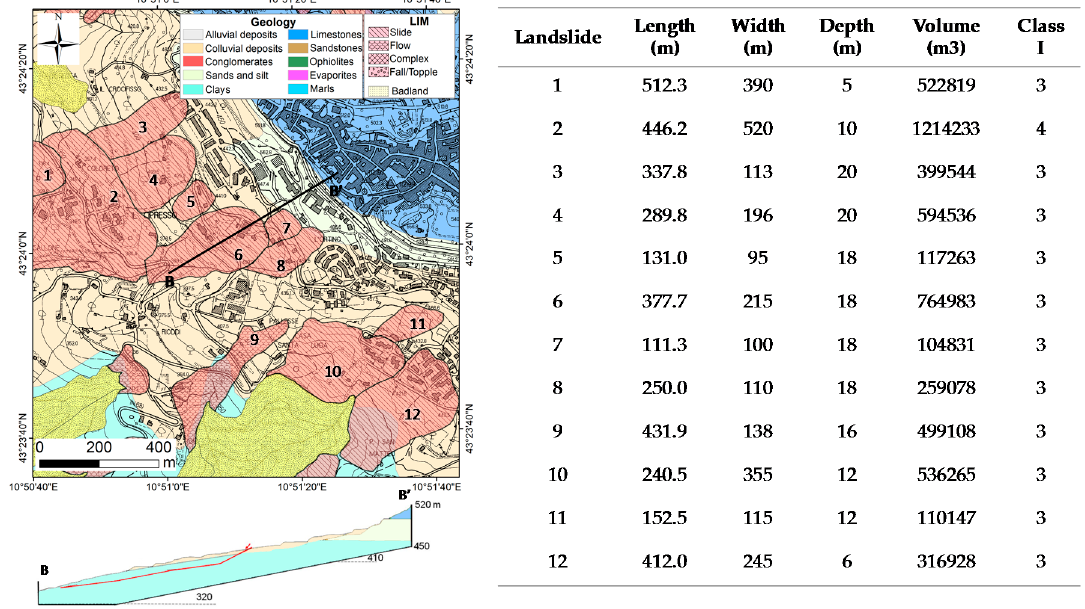
Figure 5. Close-up area whose location is shown in Figure 4: ( Left ) location of 12 known landslides overlapped on geological map and one related geological section; and ( Right ) table of morphometric parameters of known landslides and I Class.